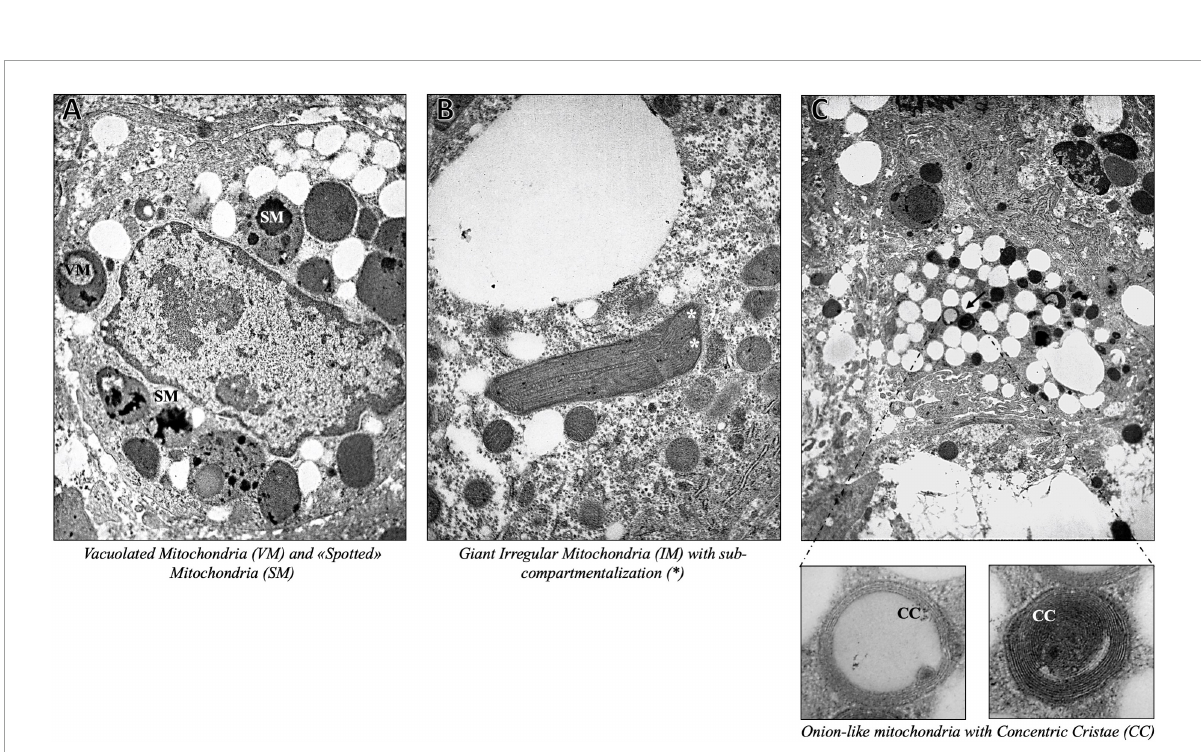
FIGURE2 Representative TEM images of onion-like giant mitochondria, defined by swirling layers of cristae membranes, obtained by ultrathin 70-nm sections of hepatic biopsy. Black arrows indicate the anomalies identified as follows: Vacuolated Mitochondria (VM) and “Spotted” Mitochondria (SM) (A) (7,000 × ), Giant Mitochondria with sub-compartmentalization (*) (B) (7,000 × ), Onion-like Mitochondria with Concentric Cristae (CC) (C) (4,400 × magnification with inserts at 30,000 ×